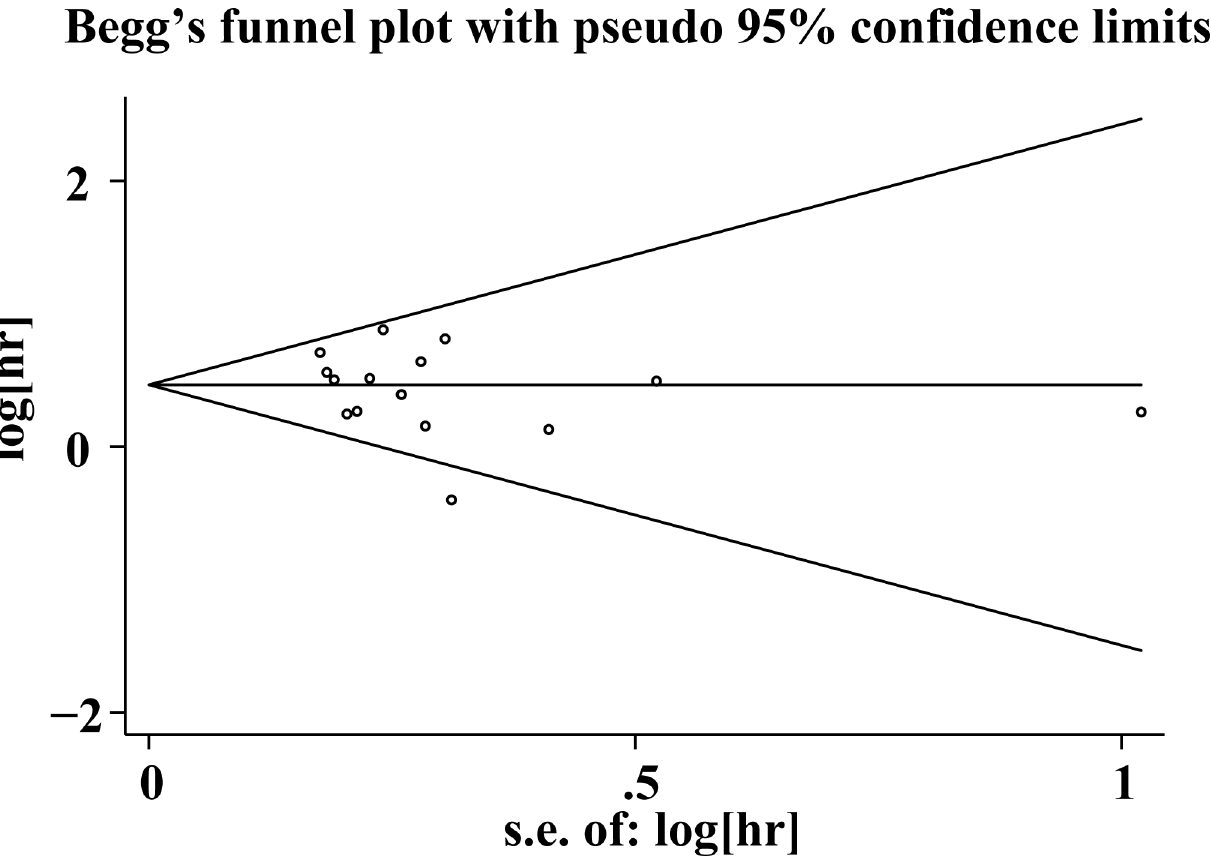
Fig 4. Funnel plots for the evaluation of potential publication bias of OS for